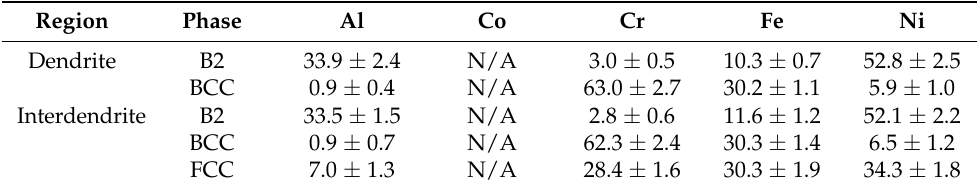
Table 7. Chemical composition (at.%) of the interior phases marked in Figures 9 and 10.